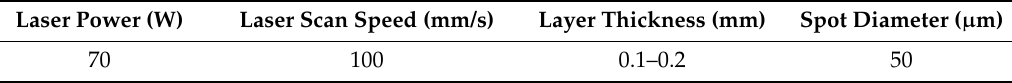
Table 1. Experiment